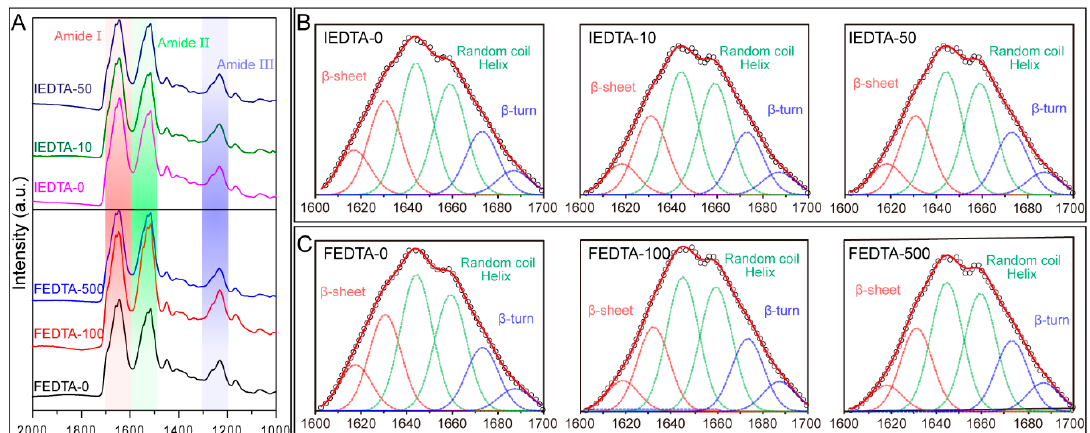
Figure 4. Synchrotron FTIR analysis of silk fiber. ( A ) S-FTIR microspectra of silk fiber with different treatment. Top, injected with EDTA. Bottom, fed with EDTA. ( B ) Deconvolution results of amide I band of injection EDTA silk fiber. ( C ) Deconvolution results of amide I band of feeding EDTA silk fiber. Black circles, original spectra; red solid curve, simulated spectra from the total peaks; dashed curve, deconvoluted peaks.